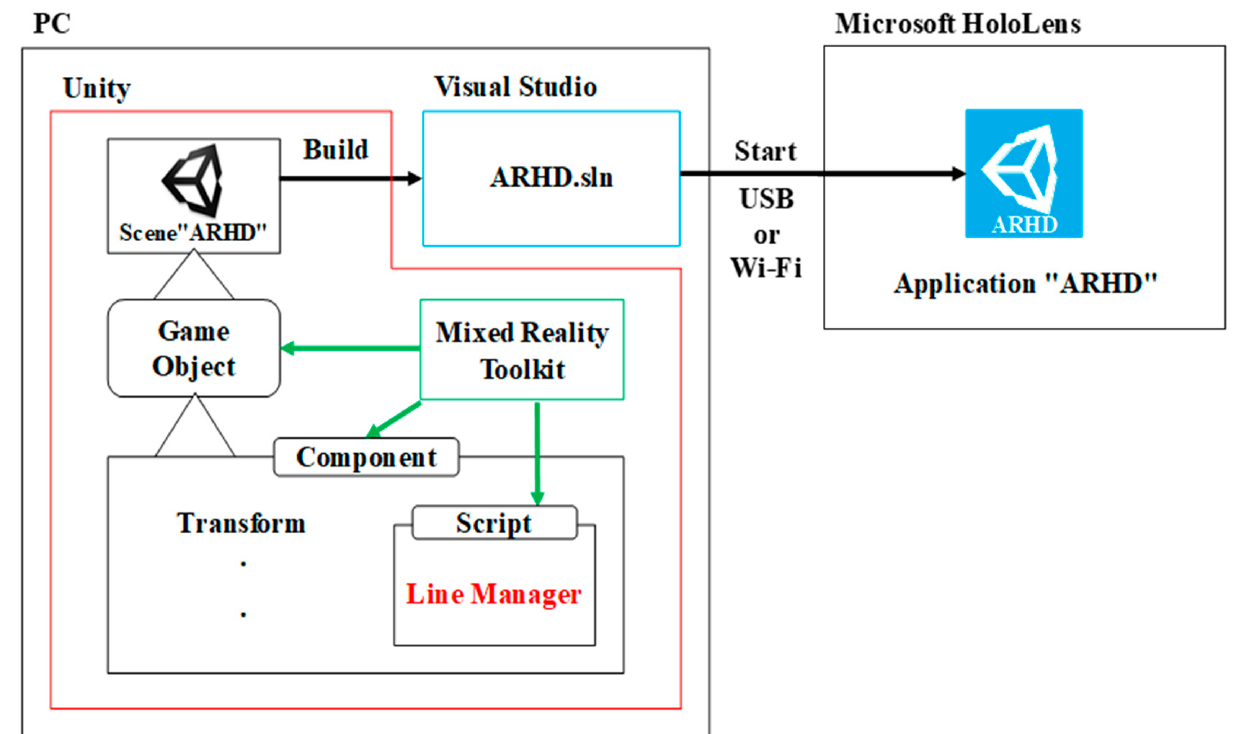
Figure 1. Schematic diagram for implementation of ARHD.